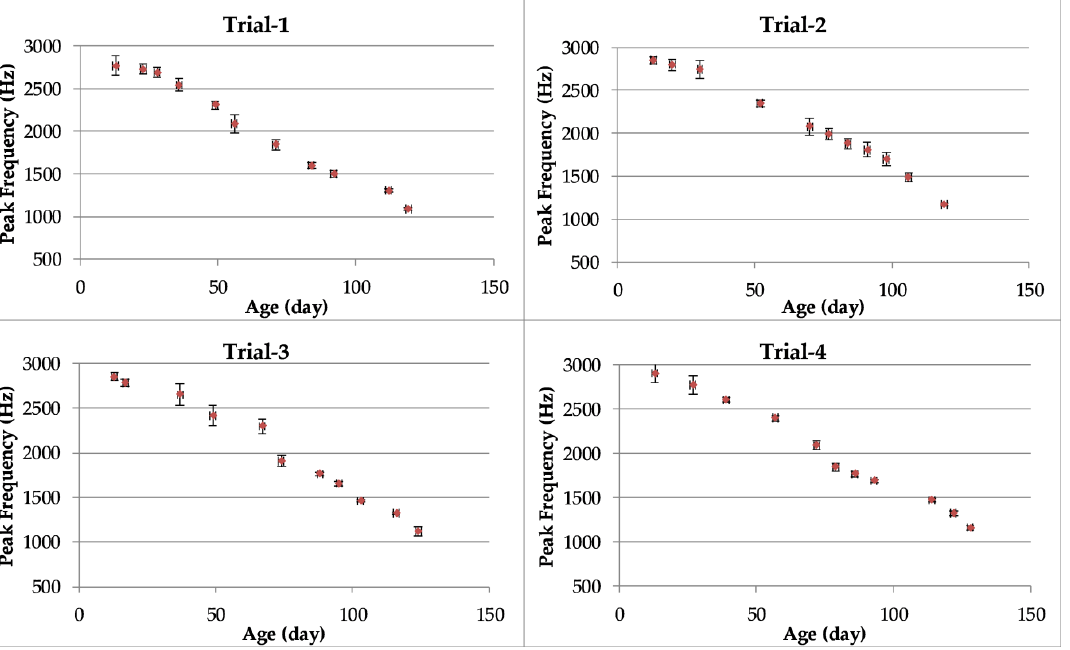
Figure 3. Means and standard error (bars) of the peak frequency of bird vocalizations as a function of turkey age.